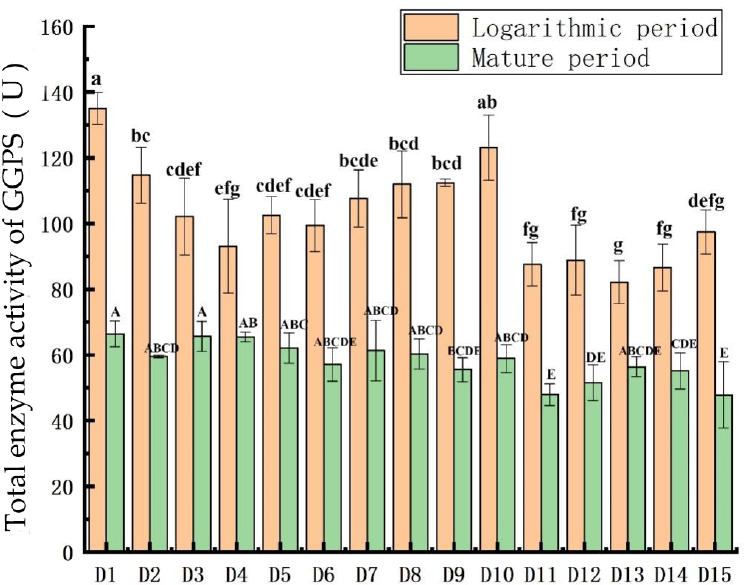
Figure 5. Comparison of GGPS activity in the 15 Dunaliella strains. The letters a–g and A–E in the figure represent the single-factor significant difference analysis of the GGPS total enzyme activity content of 15 Dunaliella strains in the logarithmic and mature stages, respectively. When the letters marked on different Dunaliella species are the same, it means that there is no significant difference between them, and when the letters are different, it means that there is a significant difference.